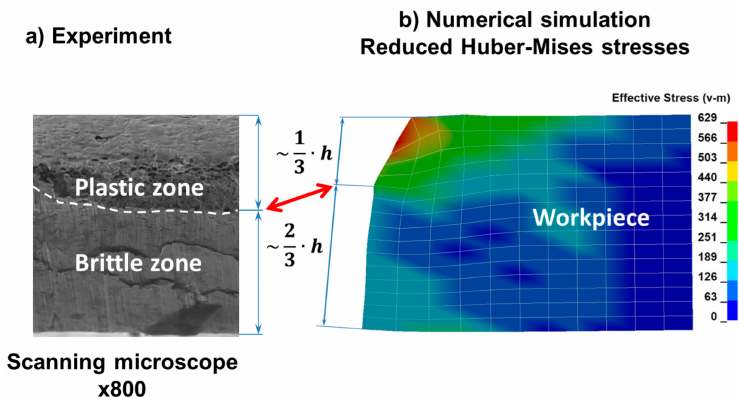
Figure 8. Final phase of a cutting process (cracking of sheet being cut).